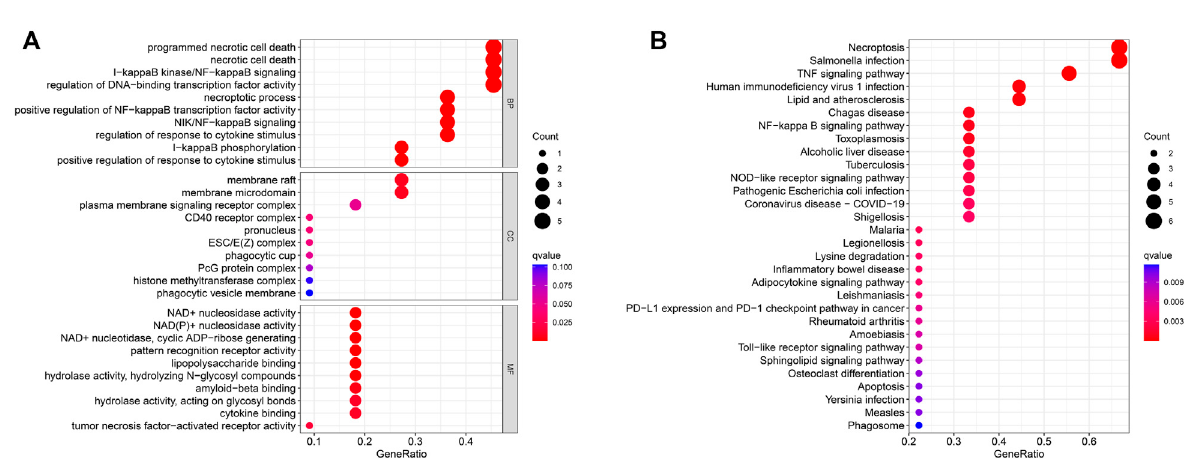
FIGURE 6 GO enrichment analysis (A) and KEGG enrichment analysis (B) of the 11 prognostic NRGs. The size of the circles in the graph indicates the number of genes enriched in the mechanism or pathway, and the color of the circles indicates the q -value.